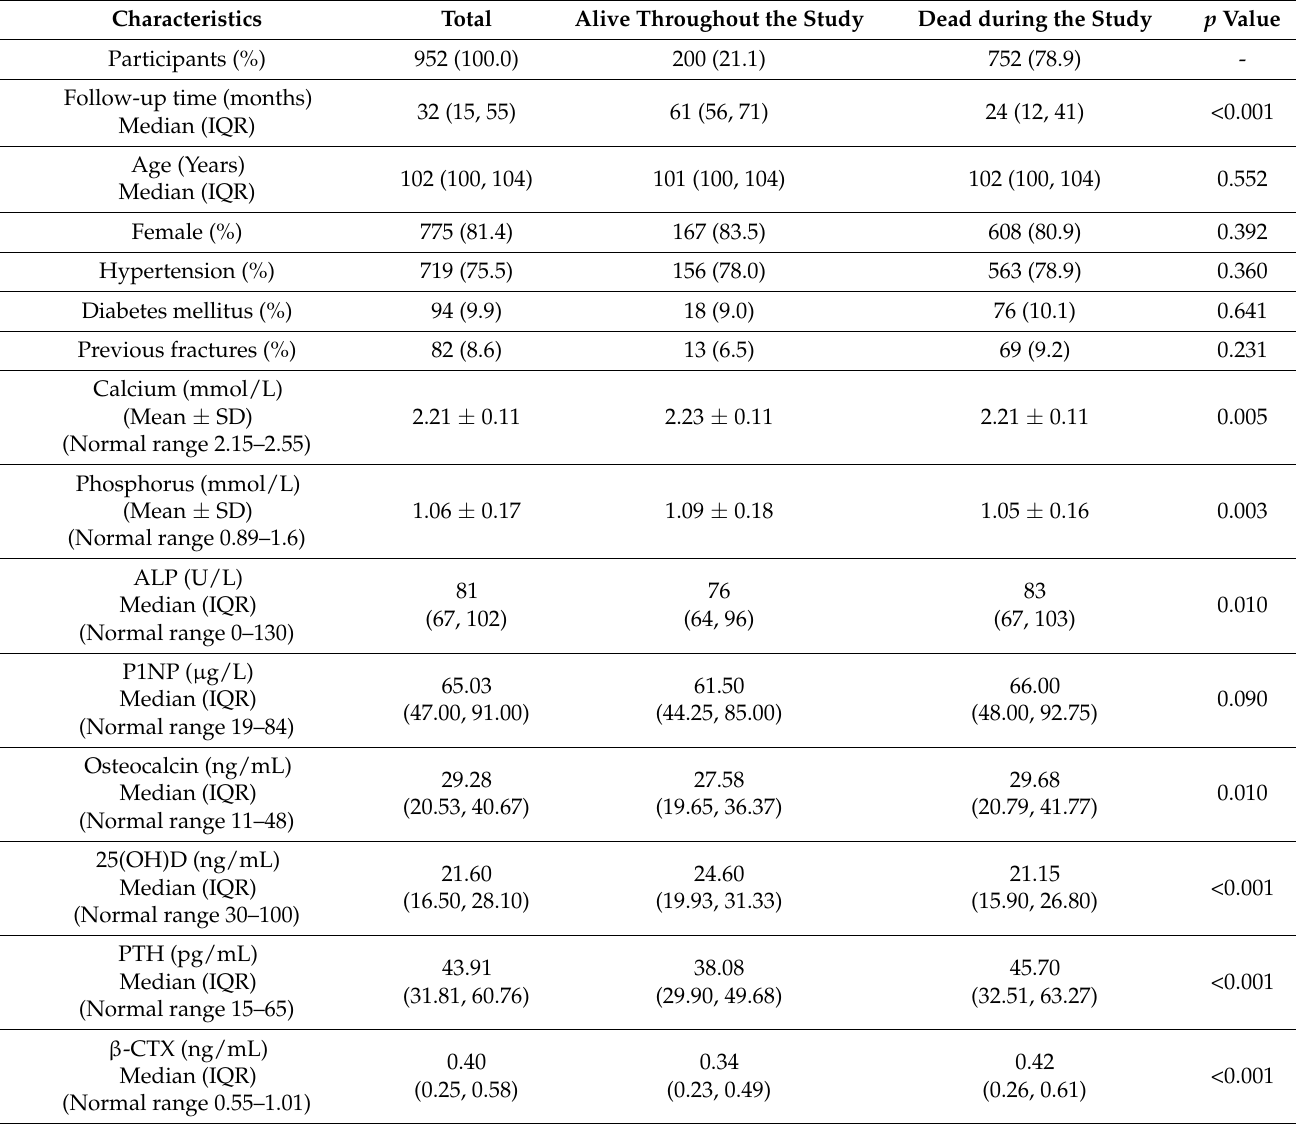
Table 1. Baseline demographic and clinical characteristics of the entire cohort of